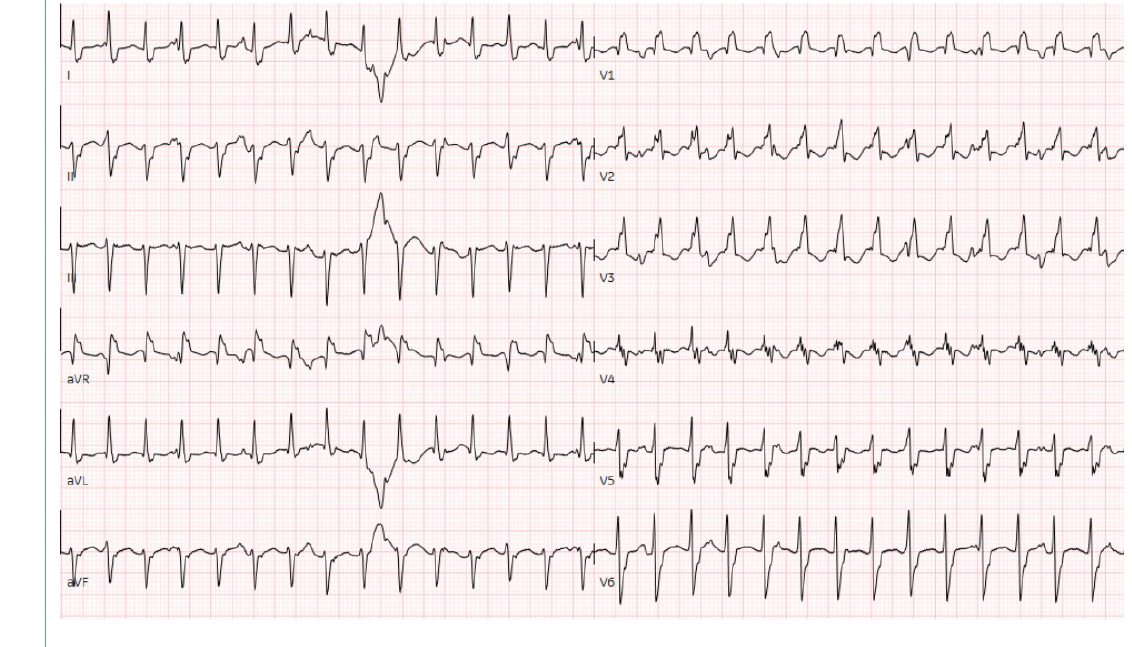
Figure 1: Twelve-lead electrocardiography at admission showed the wide complex ventricular tachycardia with a heart rate of 176 per